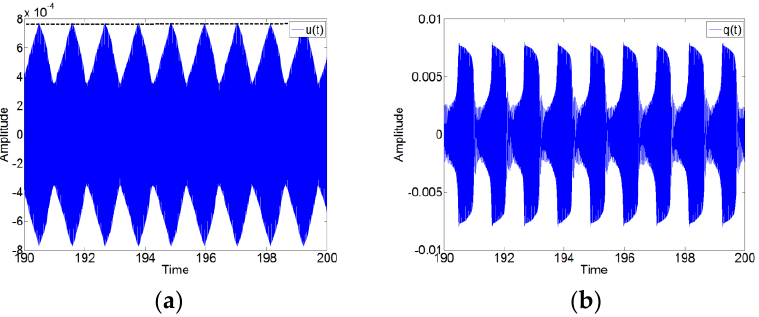
Figure 6. The time series for the displacement u ( t ) and q ( t ) with the forcing level F 1 = 1.2 and the excitation frequency 79.9 Hz. ( a ) u ( t ) and ( b ) q ( t ) . The dashed and black line represents the plateau of the amplitude of u 1 .